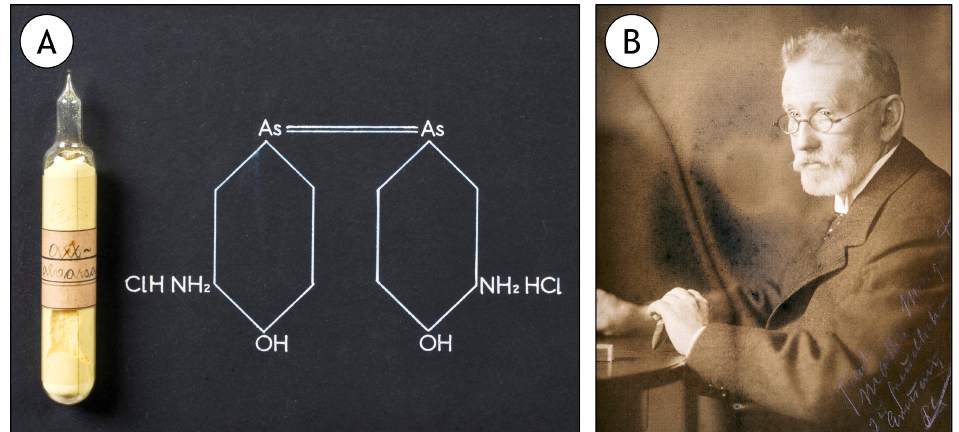
Figure 2. The first true biomedical drug (1910) was an anti-syphilitic drug based on the environmental carcinogen As. ( A ) Surviving original ampoule and formula of Salvarsan (Arsphenamine). ( B ) Salvarsan’s inventor, Paul Ehrlich (1854–1915). Both images were retrieved from the public domain and are subject to a Creative Commons Attribution (CC BY 4.0) licence. Credit to the Science Museum (London) and the Wellcome Collection (London) for panels A and B, respectively.